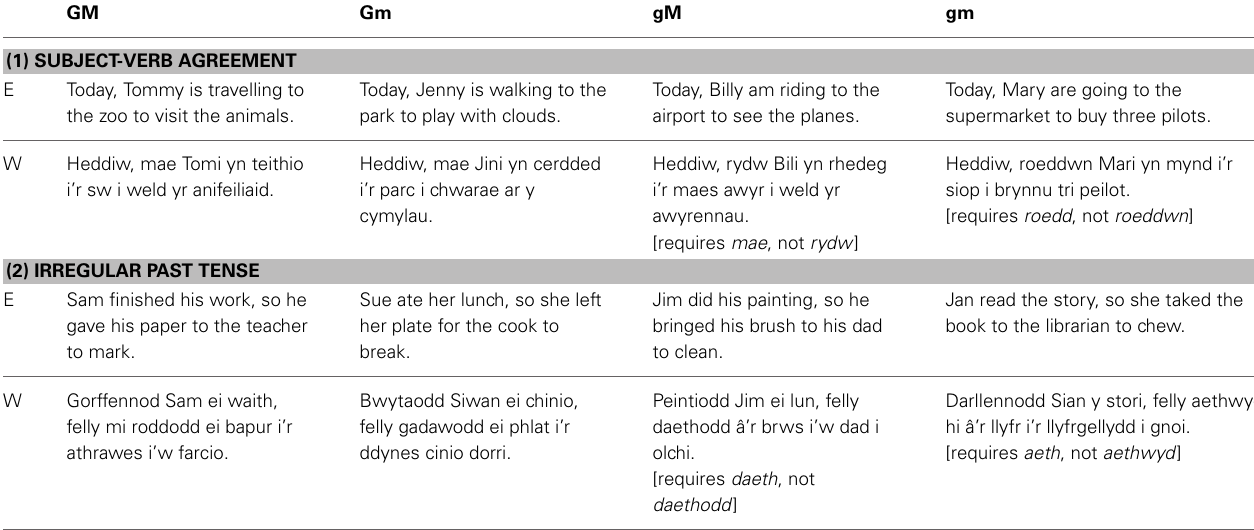
Table 4 | Sample sentential stimuli for the metalinguistic